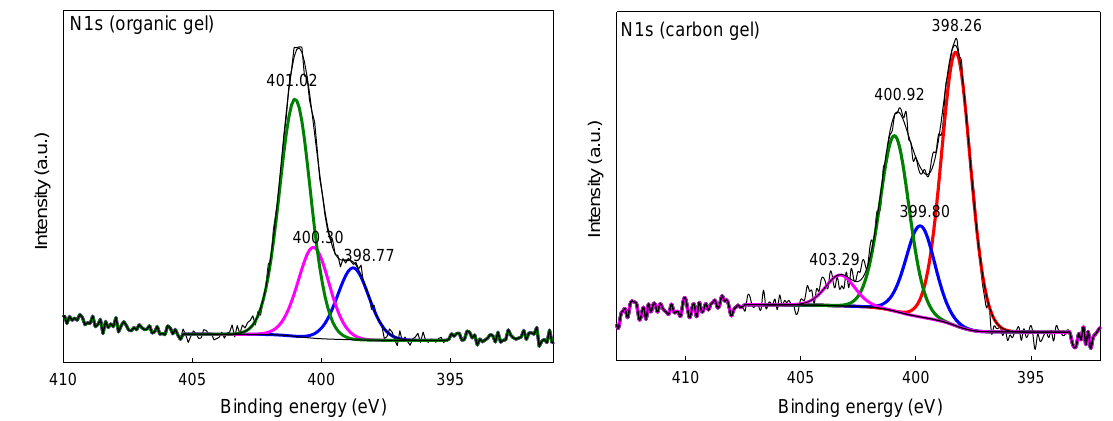
Figure 7. Comparison of high resolution XPS spectra of N 1s of organic and corresponding carbon gels obtained from imidazole-2-carboxaldehyde via pyrolysis at 750 °C.